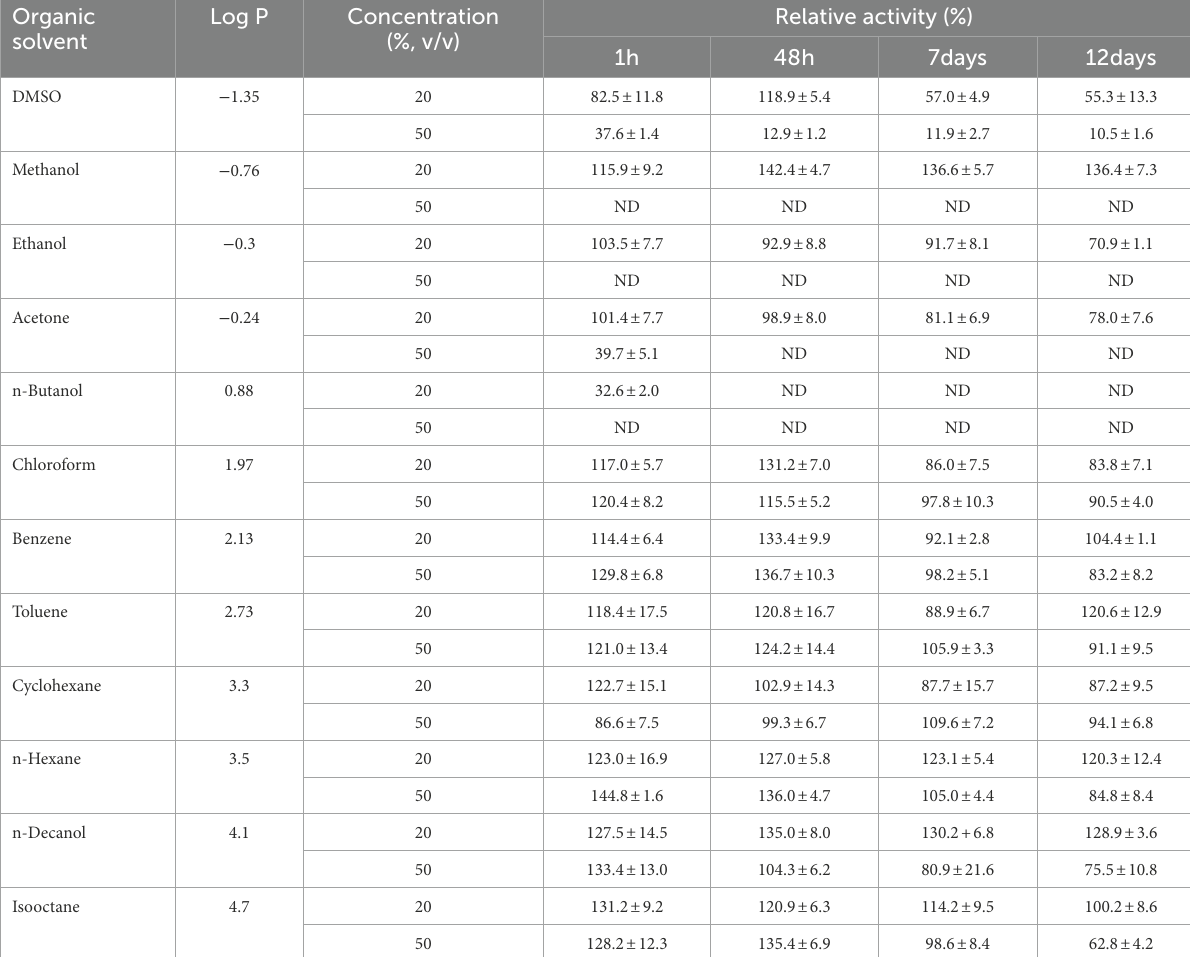
TABLE 3 The effects of various organic solvents on the stability of Lip54q. Organic